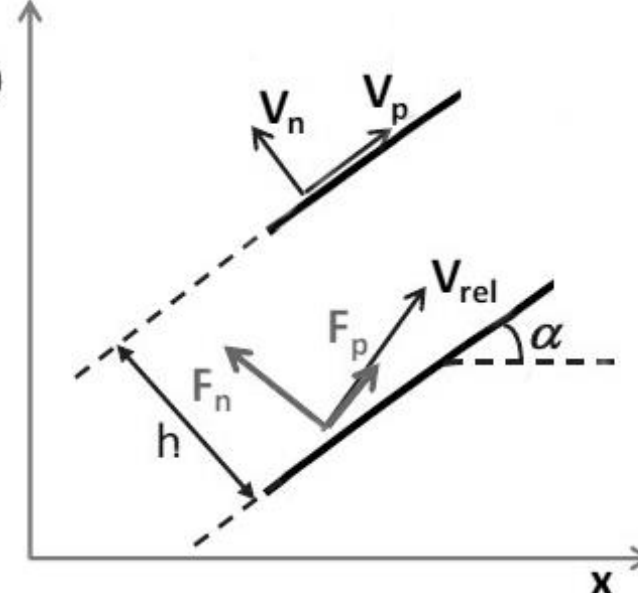
Figure 1. Illustration of body forces parallel and normal to the local flow.